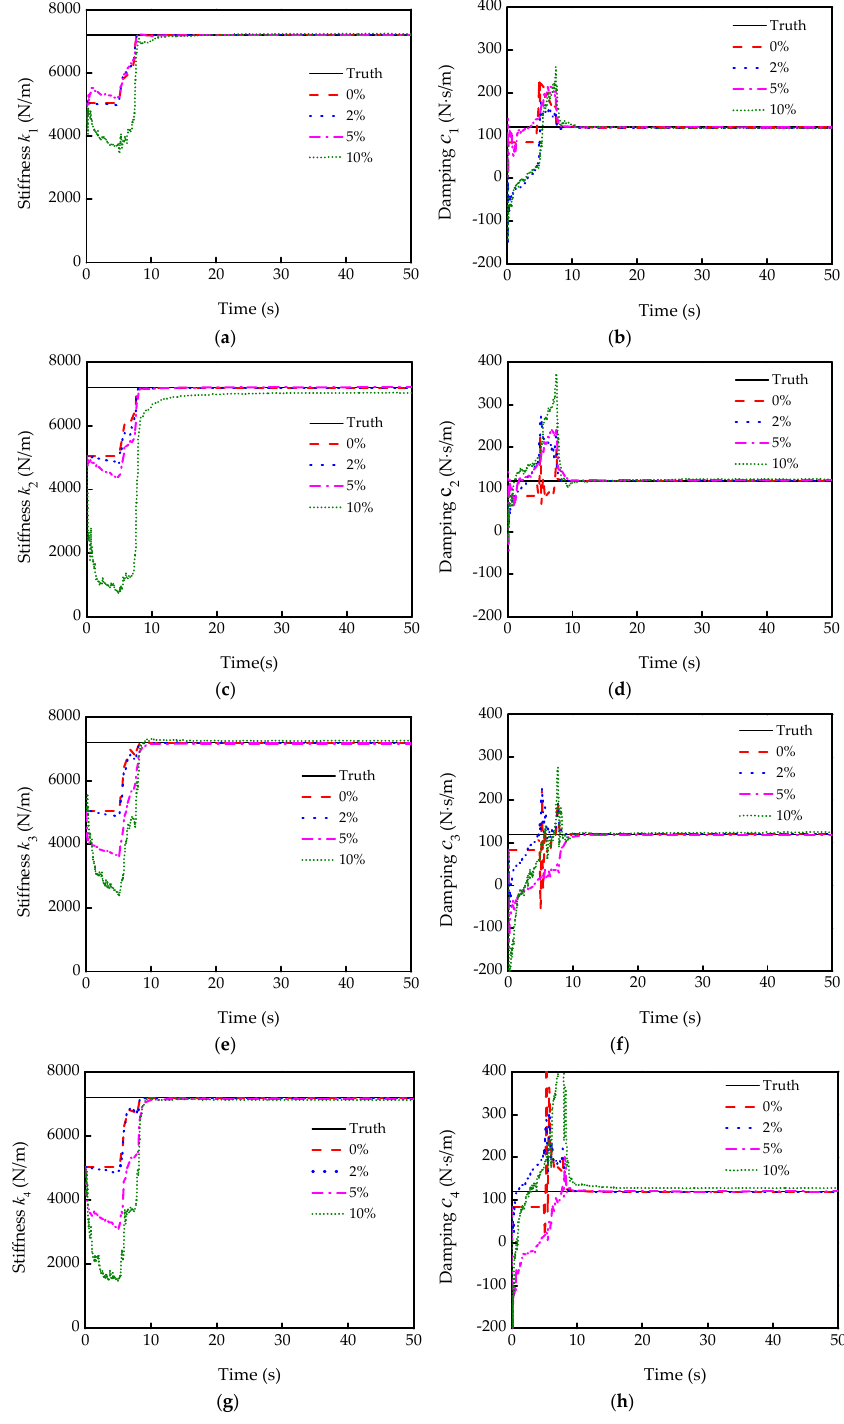
Figure 8. Identification results under different Gaussian noise levels: ( a , c , e , g ) are the stiffness k 1 , k 2 , k 3 , and k 4 , respectively; ( b , d , f , h ) are the damping c 1 , c 2 , c 3 , and c 4 , respectively.